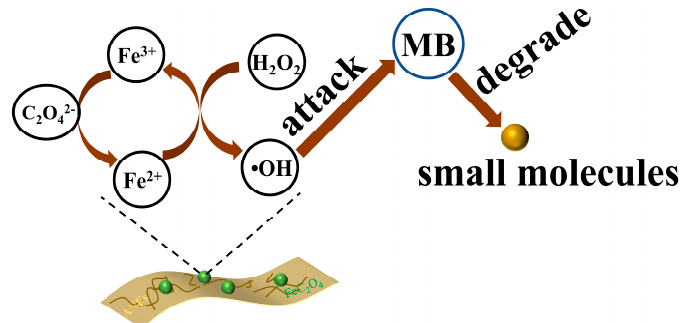
Polymers 2022 , 14 , x FOR PEER REVIEW Figure 9. The MB degradation process of composite Fenton catalyst film. Figure 9. The MB degradation process of composite Fenton catalyst film.